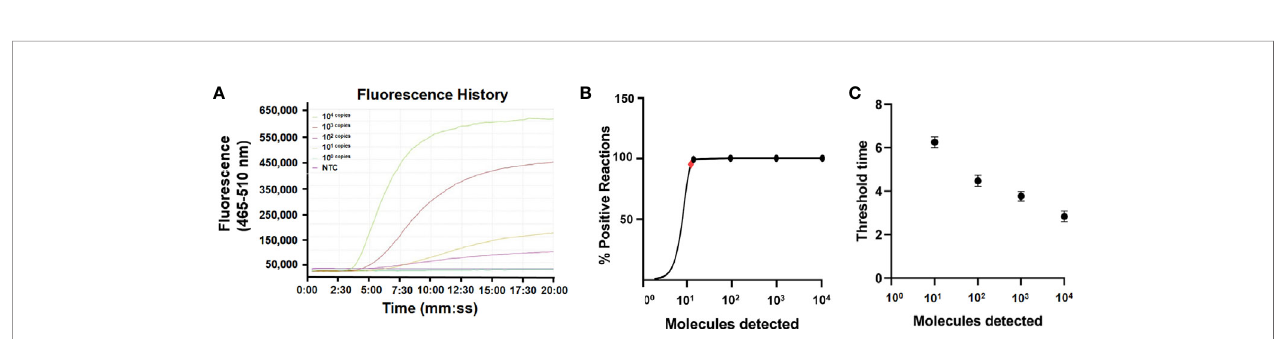
FIGURE 3 | Limit of detection of the real-time RPA assay. (A) The fl uorescence history diagram of the results of real-time RPA with different amounts (in copies) of the swp gene fragment. The amounts tested are indicated with different colors. The NTC is the no-template control. The diagram was one typical outcome of eight independent experiments. (B) Probit regression analysis of the data collected from the eight real-time RPA repeats using SPSS software (IBM, Armonk, NY, USA). The limit of detection at 95% probability (13 copies/reaction) is depicted by a red rhomboid. (C) Semi-logarithmic regression analysis of the data collected from the eight real-time RPA repeats using GraphPad Prism 8.0 (GraphPad Software Inc). The run time (threshold time) of the real-time RPA was 3 – 7 min for the templates at 10 4 – 10 0 copies/reaction.